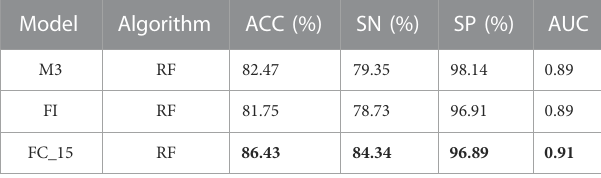
TABLE 5 Performance comparison of models based on feature